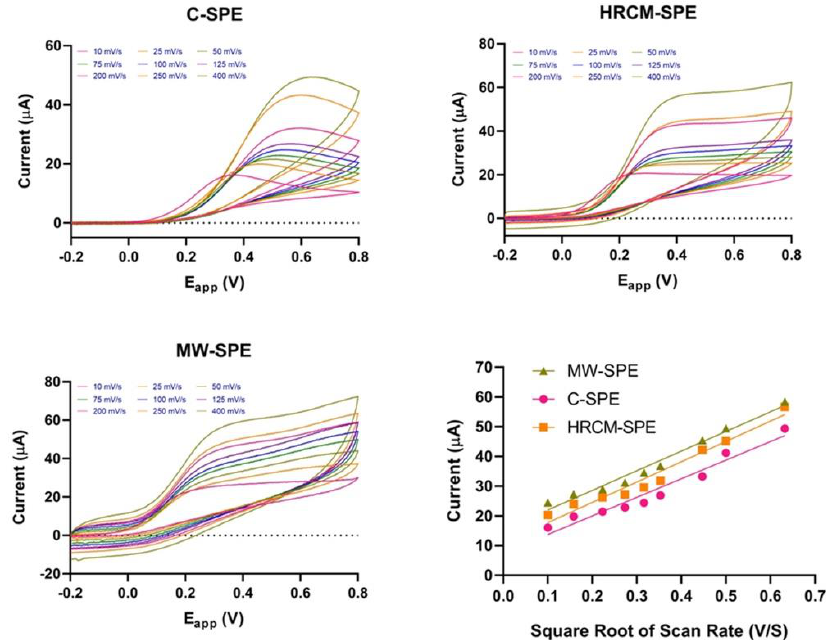
Figure 4. Cyclic voltammograms between a − 0.2 and +0.8 V potential range (E app ) vs. an Ag/AgCl pseudo-RE, of 2 mM AA at C-SPEs, HRCM-SPEs, and MW-SPEs with various scan rates of 0.01, 0.025, 0.05, 0.075, 0.1, 0.125, 0.2, 0.25, and 0.4 V. CVs were performed with the C-SPE and HRCM- SPEs functionalized with 5 mg/mL HRCM/DMF and MW-SPEs functionalized with 10 mg/mL MWCNTs/DMF. A plot of the AA current (µA) versus the v 1/2 (V/s) is reported in the lower right part of the figure.